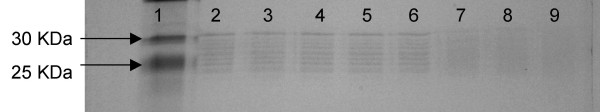
SDS PAGE analysis of V8 protease irradiated with methylene blue and laser light doses of 1.93 J/cm2, 3.86 J/cm2 and 9.65 J/cm2. V8 protease was either kept in the dark (L-) or irradiated with laser light doses of 1.93 J/cm2, 3.86 J/cm2 and 9.65 J/cm2 (L+) in the presence of an equal volume of either PBS (S-) or 20 μM methylene blue (S+). Following irradiation, samples were analysed by SDS PAGE using a 5% stacking gel and 15% resolving gel under denaturing conditions. Lane 1: molecular weight marker, lane 2: L-S-, lane 3: L-S+, lane 4: L+S- (1.93 J/cm2), lane 5: L+S- (3.86 J/cm2), lane 6: L+S- (9.65 J/cm2), lane 7: L+S+ (1.93 J/cm2), lane 8: L+S+ (3.86 J/cm2), lane 9: L+S+ (9.65 J/cm2). L = samples exposed to laser light and S = samples exposed to 20 μM methylene blue. The apparent molecular mass of the V8 protease was approximately 30 kDa.